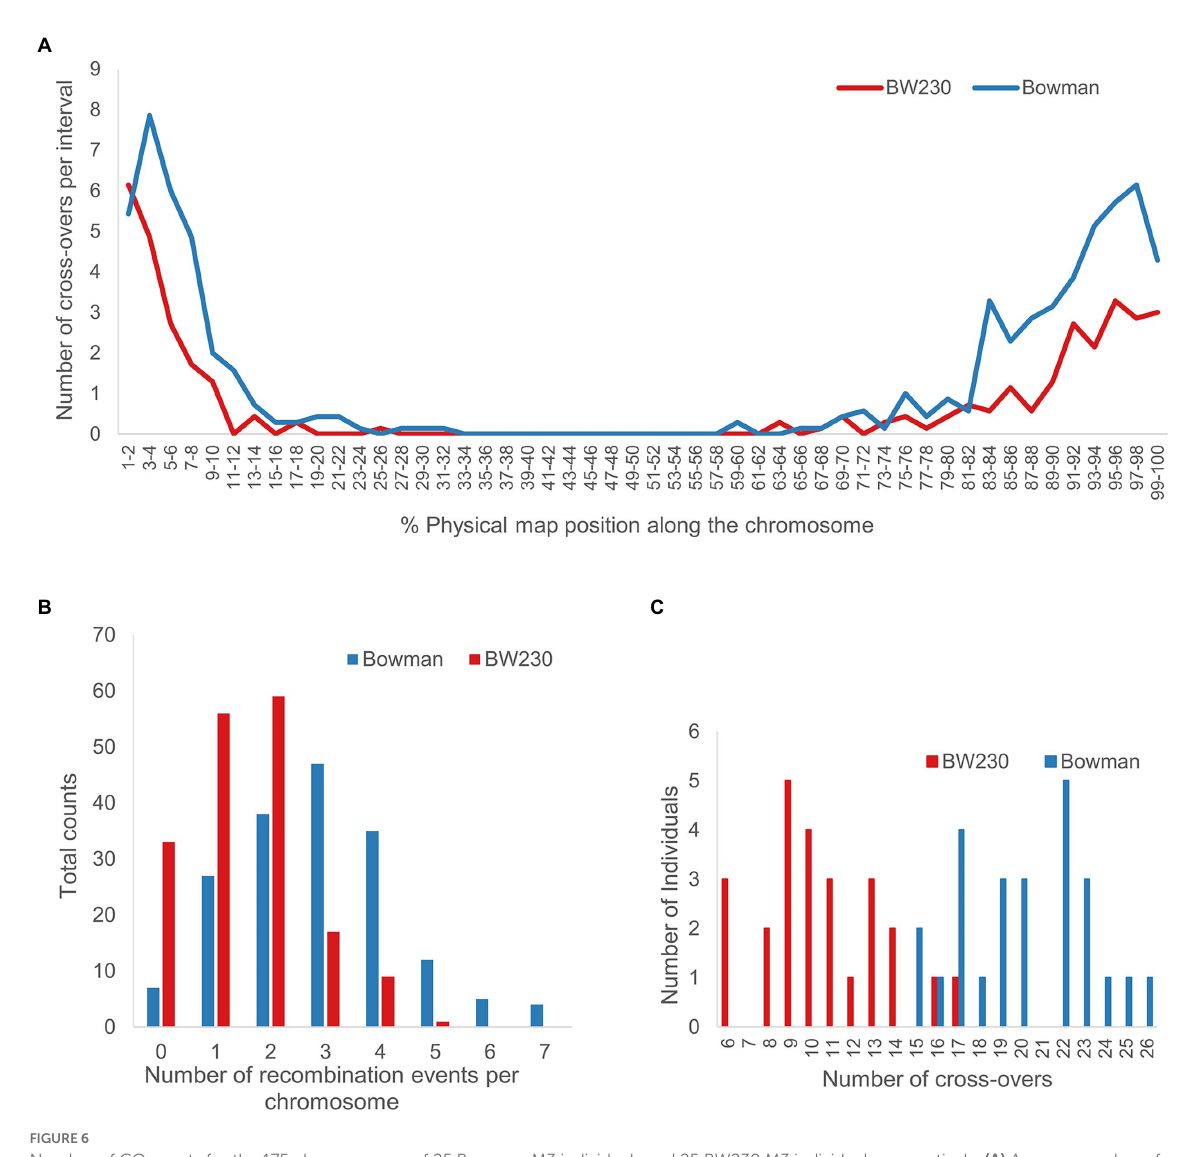
FIGURE 6 Number of CO events for the 175 chromosomes of 25 Bowman M3 individuals and 25 BW230 M3 individuals, respectively. (A) Average number of CO across all chromosomes per 2% intervals along the physical map. (B) Total counts of CO per individual chromosome. (C) Total number of CO per individual plant. Average number of CO for Bowman wildtype (blue) was 20.16 ± 3.1 and a median of 20. Average number of CO for BW230 was 10.64 ± 2.9 and a median of